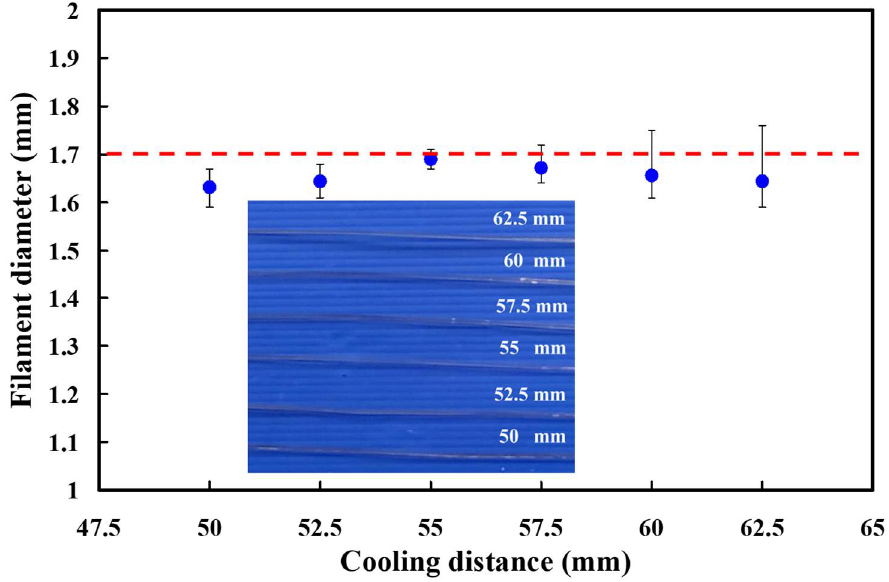
Figure 5. Effects of the cooling distances on the PLA filament diameter.